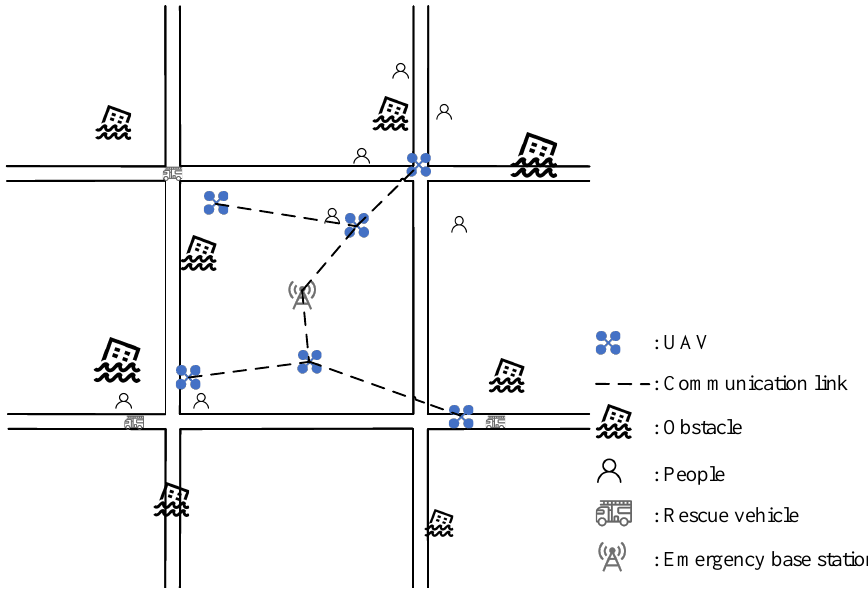
Figure 7. Simulation for the Multi-UAVs emergency